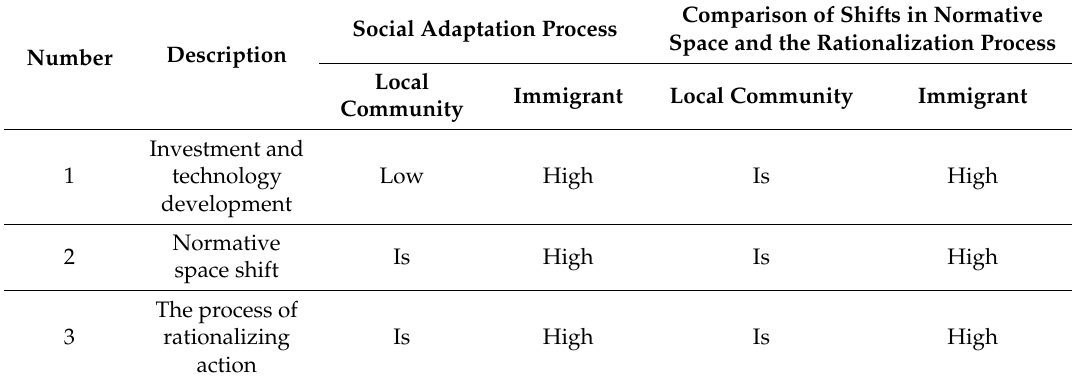
Table 4. Comparison of social adaptation processes, normative space shifts, and rationalization of